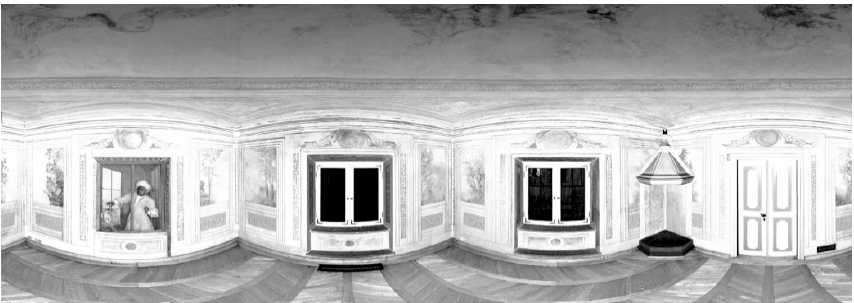
Figure 3. The point cloud in the spherical projection of Test Site II: “The Chamber with a Parrot” without marked points [27].